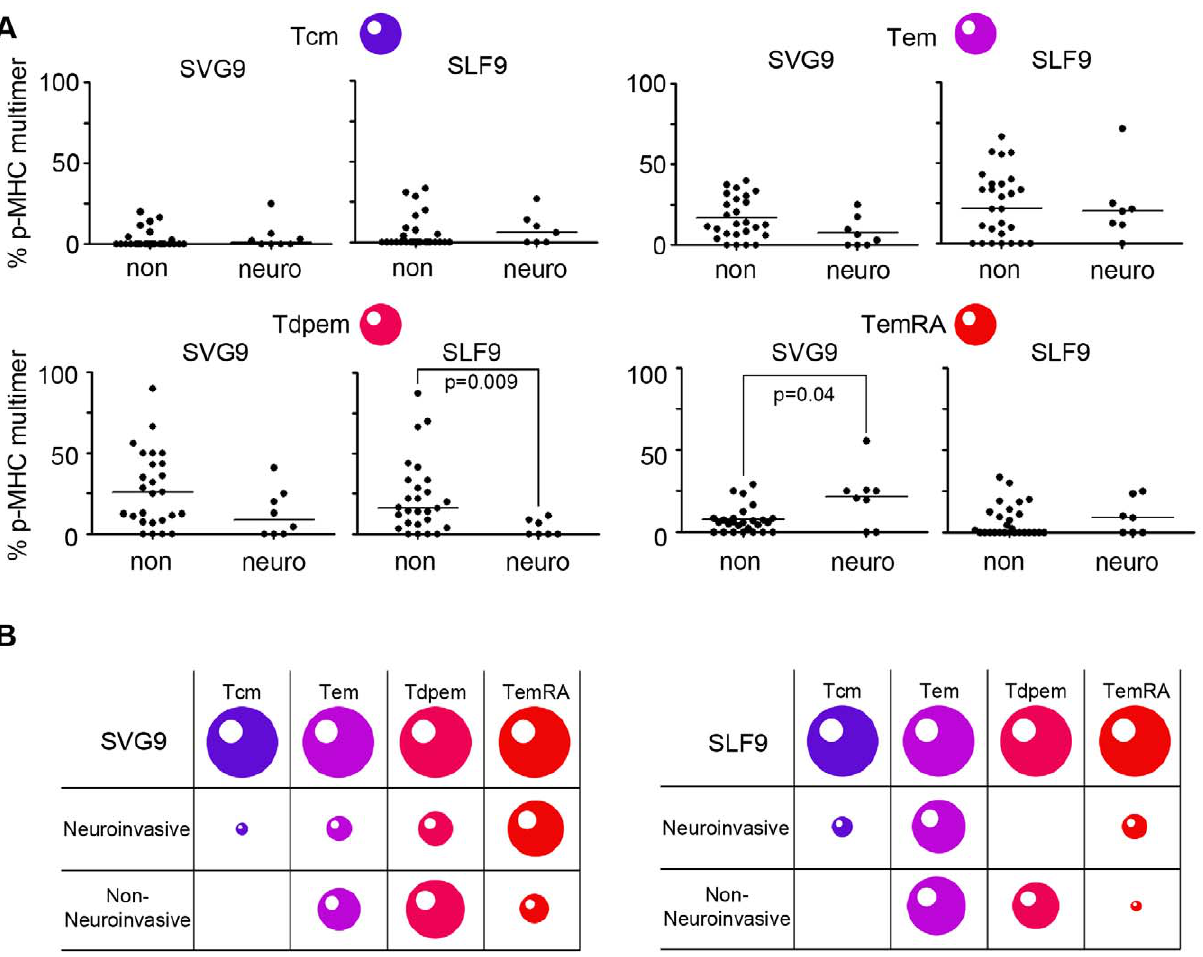
Figure 4. Distinct Phenotype of SGV9 and SLF9 specific cells correlate with neuroinvasive symptoms. (A) Memory phenotypes of antigen experienced T cells from donors with or without neuroinvasive symptoms are shown, based on expression of CD27, CD45RA, CCR7, CD57 as defined in Table 2. For data of a normal distribution, lines represent mean values and p values are from a student t-test analysis. For data of a non- normal distribution, lines represent median values and p values are from a Mann-Whitney test. (B) The size of each cell represents the median percentage of the prevalent memory phenotypes for each of the two clinical conditions.